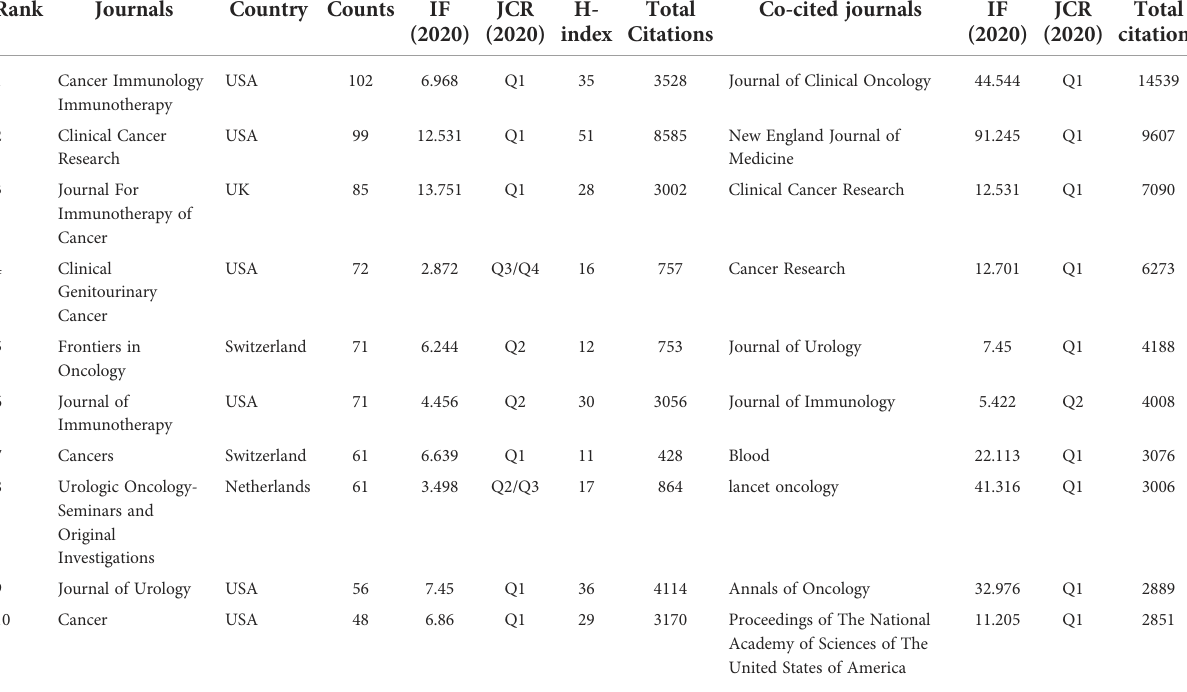
TABLE 4 Top 10 productive journals and co-cited journals in the fi eld of RCC immunotherapy.